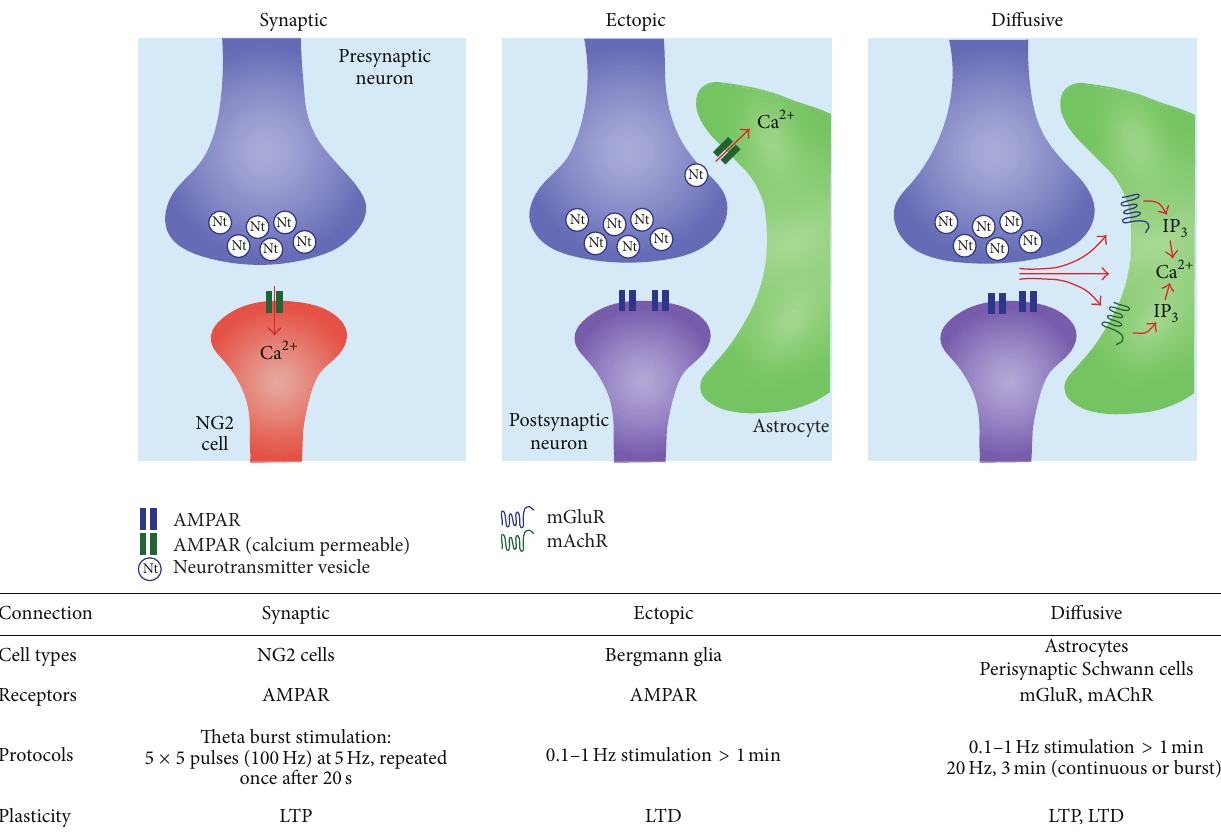
Figure 1: Modes of neuron-glial transmission and plasticity. Summary of the routes for neuron-glial transmission in which long-term plasticity after electrical stimulation of presynaptic cells has been demonstrated. Left panel shows synaptic transmission for NG2 cells (analogous to classical neuronal LTP), middle panel shows ectopic transmission at cerebellar Bergmann glia, and right panel shows volume transmission through diffusion to extrasynaptic receptors. The table shows cell types, receptors, stimulation protocols, and forms of glial plasticity that have been described. See main text for references and further